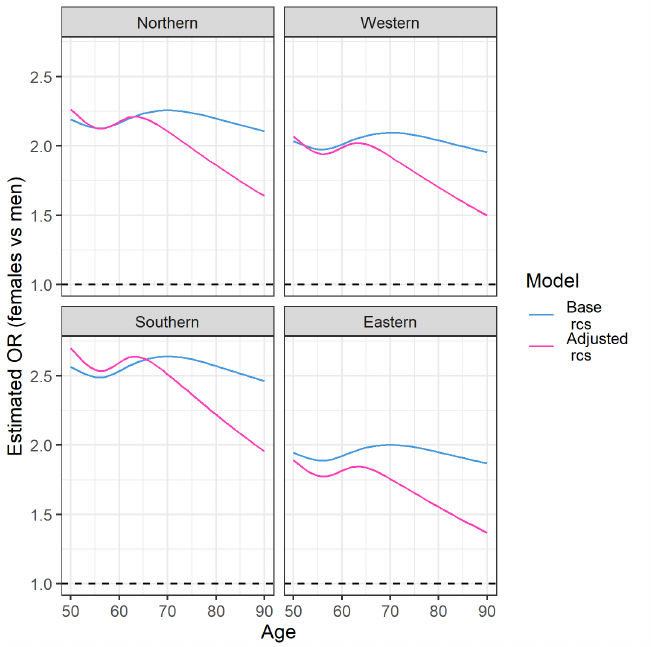
Figure A1. Sex differences by age and region in depression; OR were obtained using logistic regression models including two-way interactions between age, sex and region (base model) and additional risk factors (education, BMI, current smoking, presence of chronic disease, vigorous physical activity, living arrangement; adjusted model); age was modelled using restricted cubic splines (rcs). See Table 1 for sample sizes within each region and by sex, and for descriptive